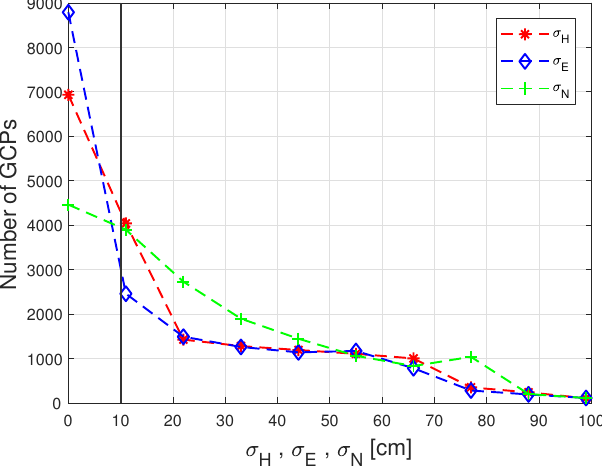
Figure 10. Histogram of GCP precision values in East σ E , North σ N and height σ H .